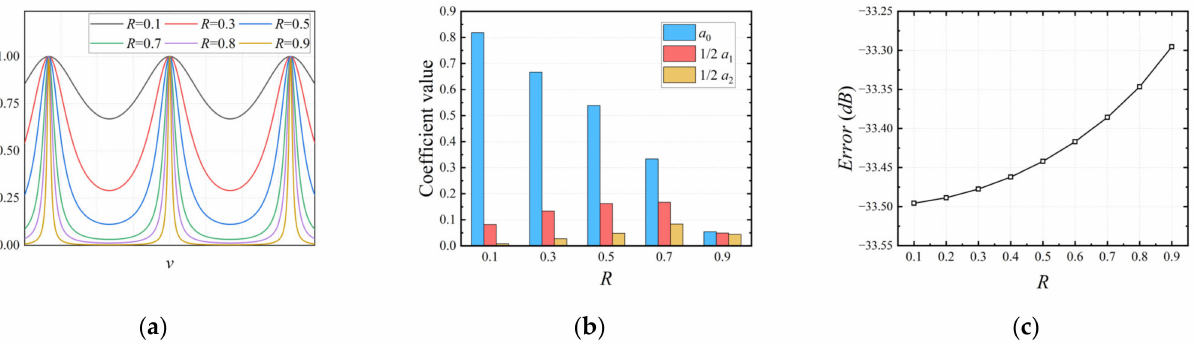
Figure 12. ( a ) The T FPI at different Rs; ( b ) the relationship between the reflectivity R and the coefficient a m ; ( c ) the curve of Error vs. the reflectivity R